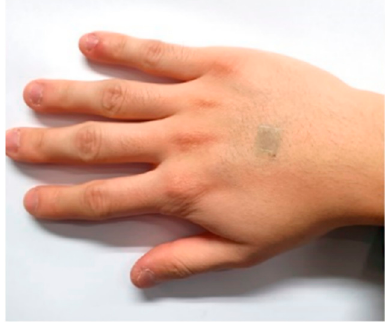
Figure 11. Transparent wireless heat patch. Reprinted with permission from Lee et al. [96]. Copyright © 2020. American Chemical Society.